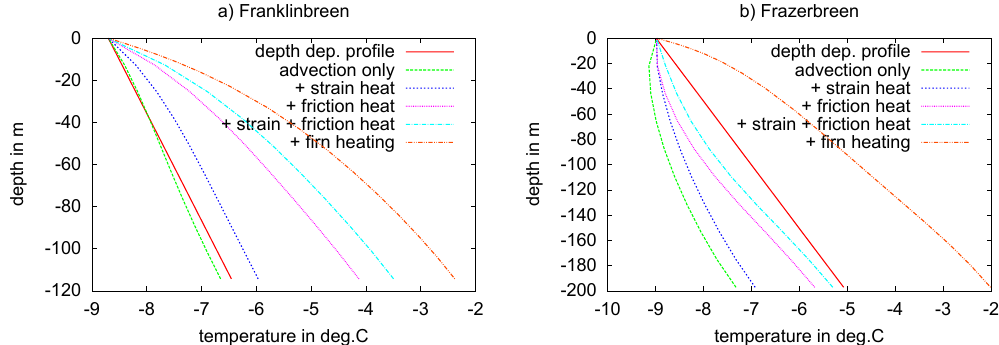
Figure 7. Temperature profiles in chosen locations (temperatures relative to pressure melting), (a) in the ablation zone of Franklinbreen and (b) in the accumulation zone of Frazerbreen: (1) depth-dependent profile (Sect. 3.2) assumed in Schäfer et al. (2012) (red), (2) profile including advection, but no additional heat sources (green) ( 1995ssA ), (3) profile including advection and strain heating (blue) ( 1995ssSH ), (4) profile including advection and friction heating (pink) ( 1995ssFH ), (5) profile including advection and both strain and friction heating (light blue) ( 1995ss ), (6) profile including also firn heating (orange), which is identical for the equilibrium state firnss and the following time-evolving simulation firnevol . The locations of these profiles are indicated in Fig.